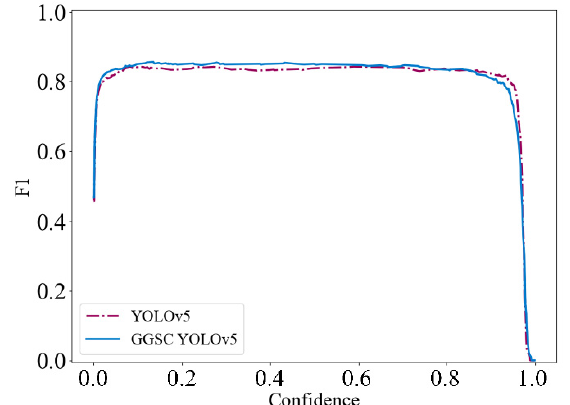
Figure 10. Comparison of the 1 F curves for before and after algorithm improvement.